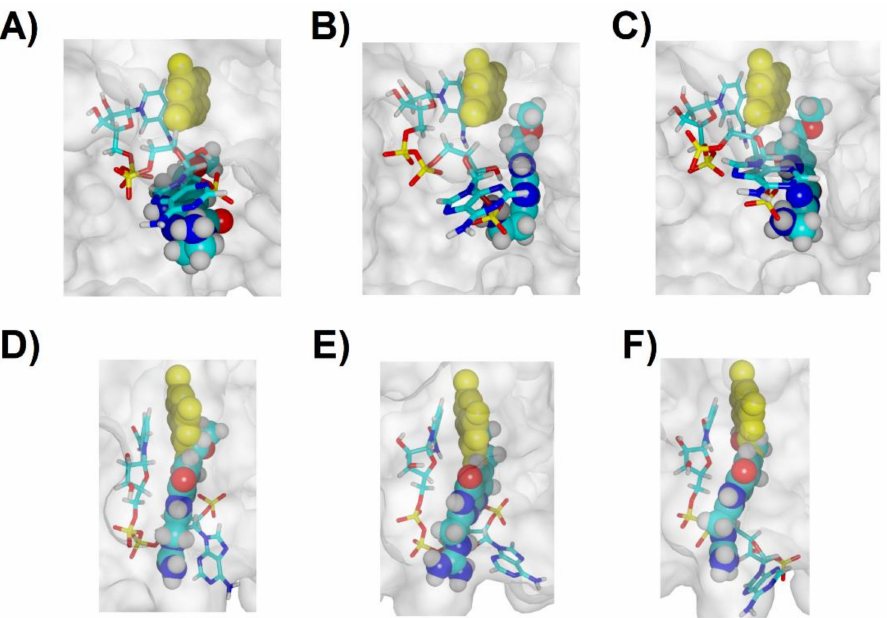
Figure 7. Final binding modes (after 50 ns) of molecule 31 ( A – C ): three replicate simulations, shown in the same relative orientation; and molecule 32 ( D – F ): three replicate simulations, shown in the same relative orientation, rotated ≈ 90 ◦ relative to the orientation of panels ( A – C ). NADPH is depicted as sticks, ligands as solid atom sphere models. In each panel, the crystallographic position (PDB:2RK1) of the dihydropterin core of folate is depicted as yellow solid atom sphere models.